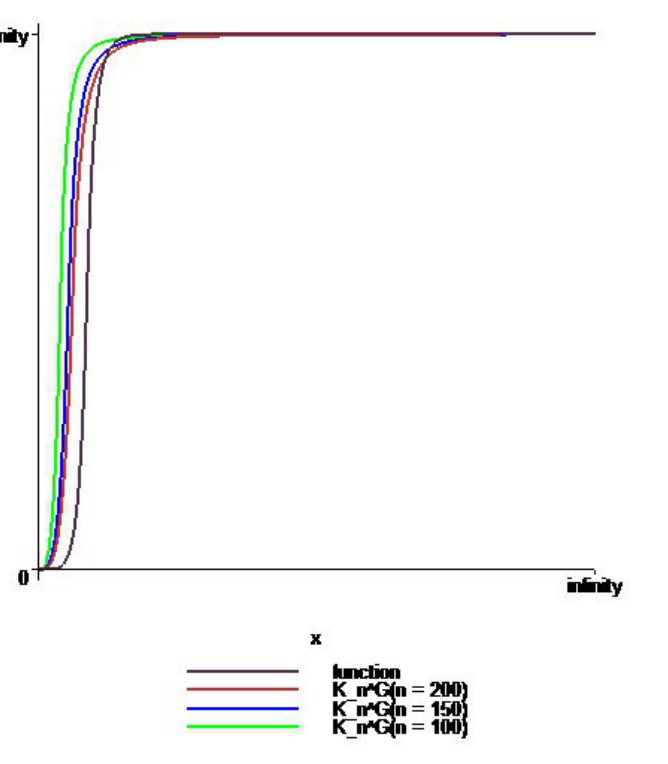
( v ; x ) (orange), K G ( v ; x ) (blue), and K G ( v ; x ) (green) to v ( x ) 200 150 100